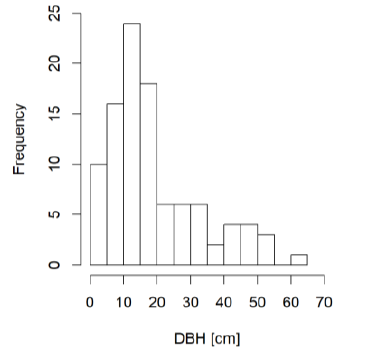
Figure 1. Histogram of the DBH values of all sampled trees (n=100)